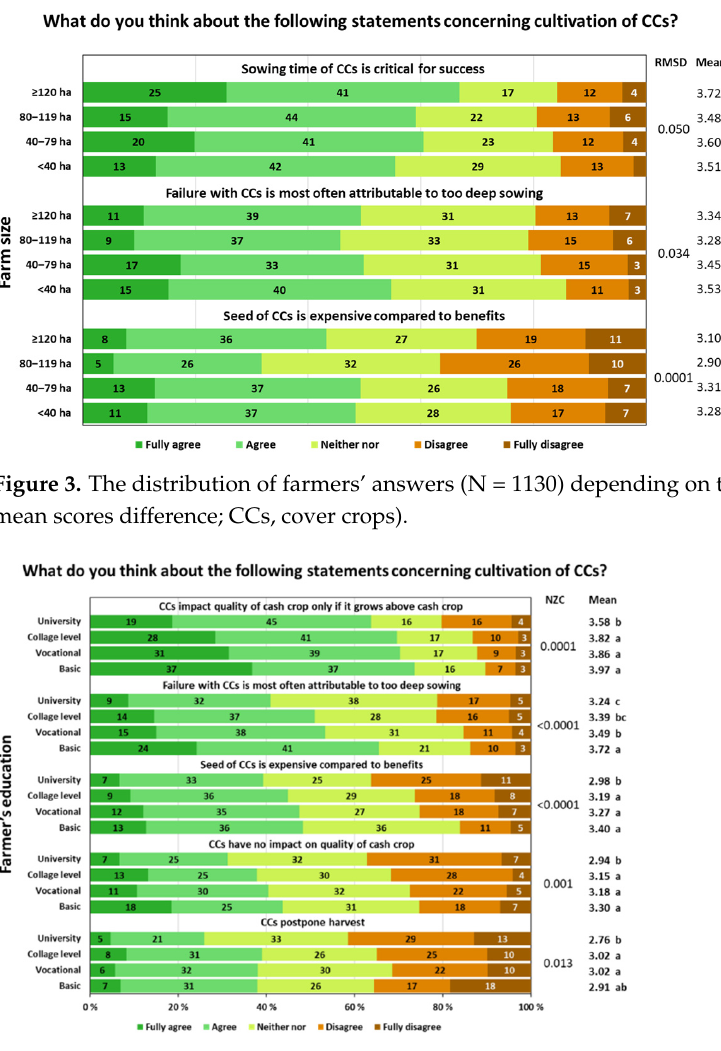
Figure 4. The distribution of farmers’ answers (N = 1130) depending on the farmer’s education (NZC, nonzero correlation; CCs, cover crops).